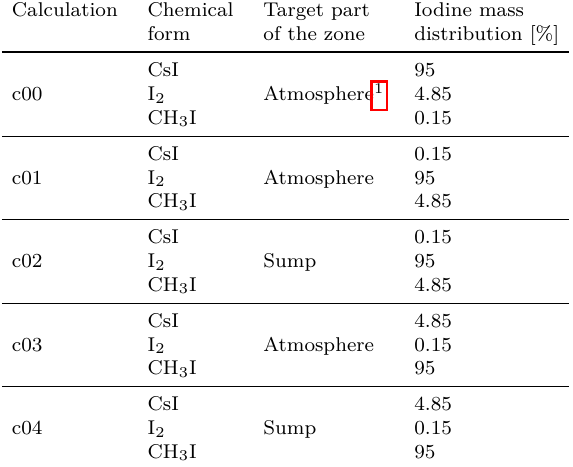
Table 3. Overview on calculated variants.